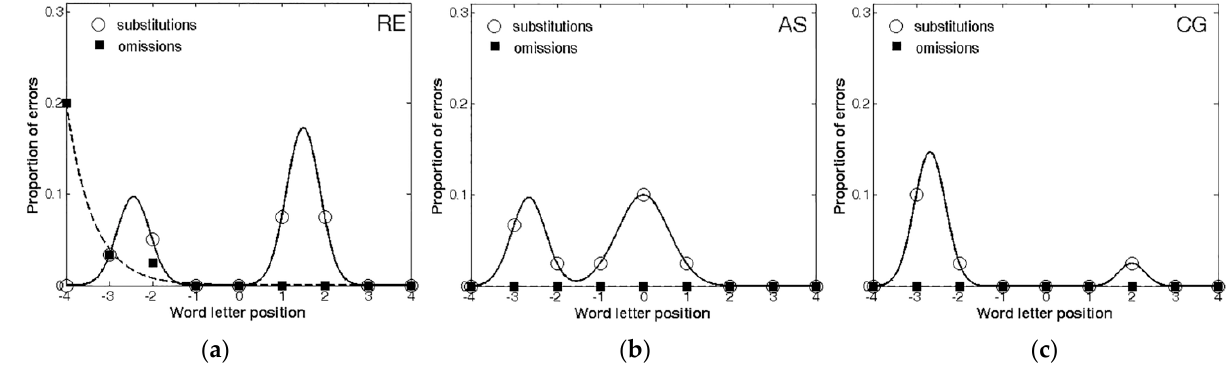
Figure 1. The distribution of omission and substitution errors made by the three patients: ( a ) RE; ( b ) AS; ( c ) CG. 0 corresponds to the central letter in the string, positive values to the letters on the right and negative values to the letters on the left.